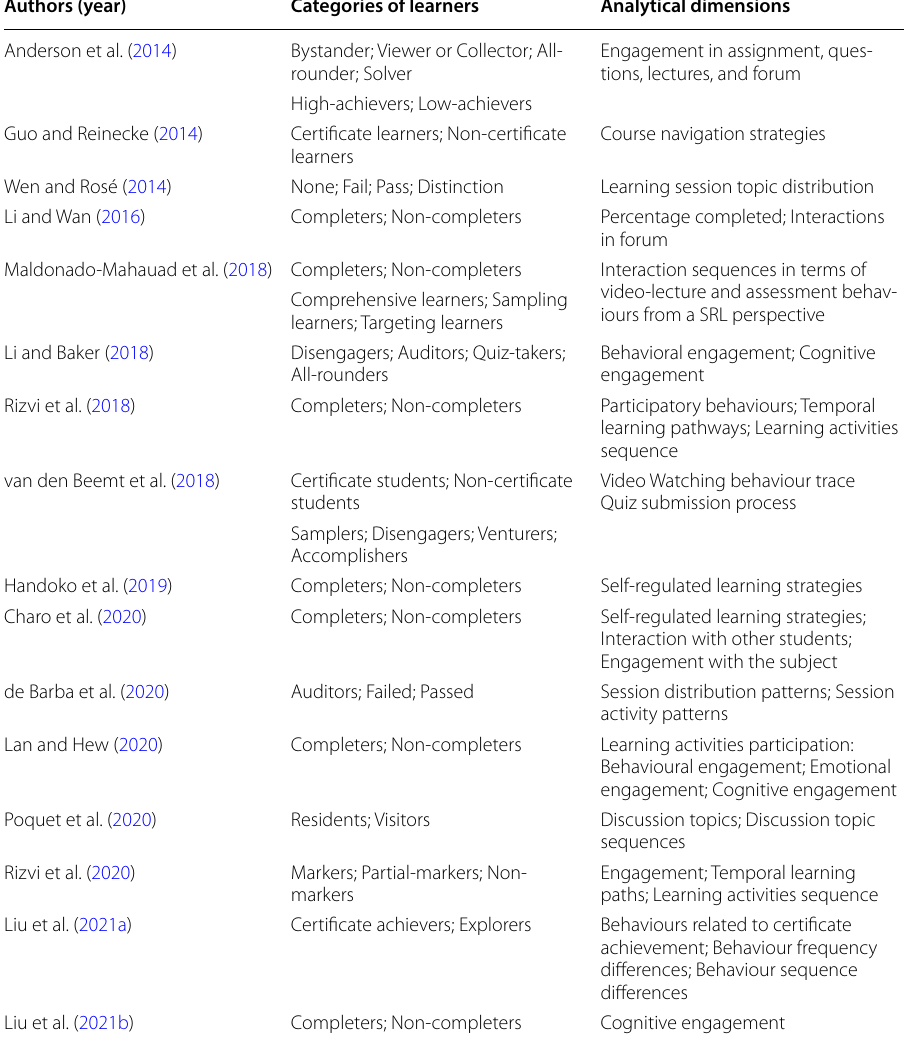
Table 1 Related literature on learning patterns of MOOC learners with different